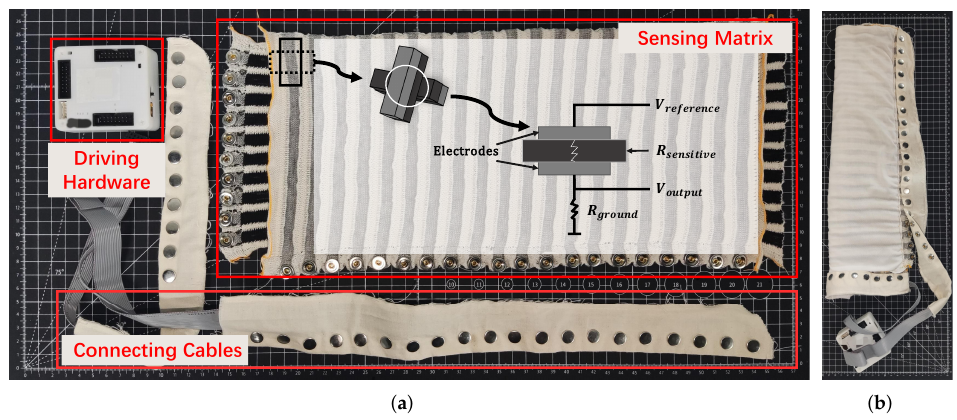
Figure 1. Smart-Sleeve. ( a ) The textile matrix. ( b ) The cable and driving hardware can be easily removed from the textile